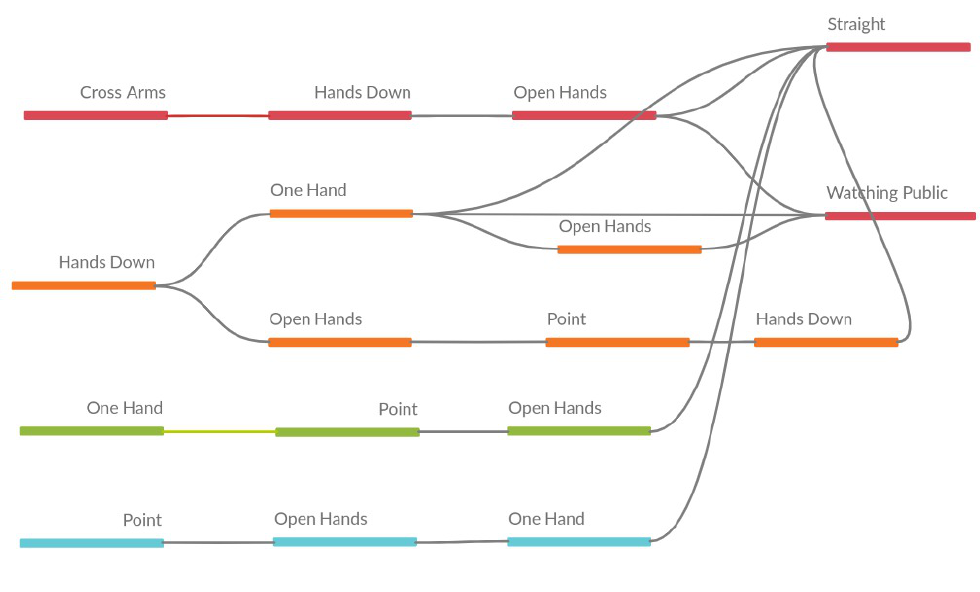
Figure 11. Visual representation of sequences from presentation 3 of year 1.